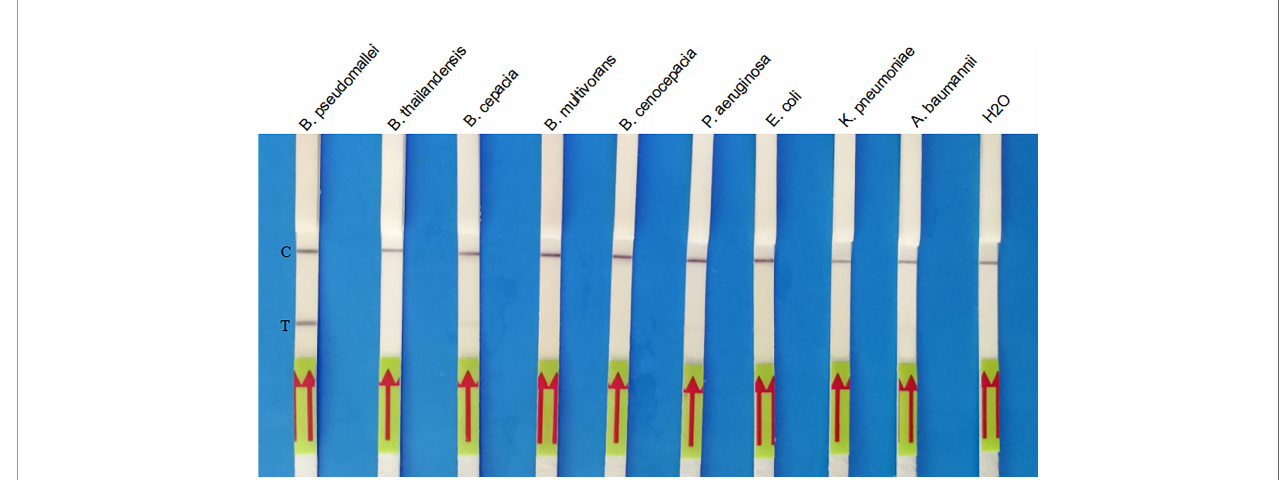
FIGURE 4 | Speci fi city of the LF-RPA assay for the orf2 gene of B . pseudomallei identi fi cation. Partial results showed that only the B . pseudomallei samples produced ampli fi cation signals, whereas the other pathogen samples and the negative control produced no ampli fi cation signals. This experiment was repeated three times with the same